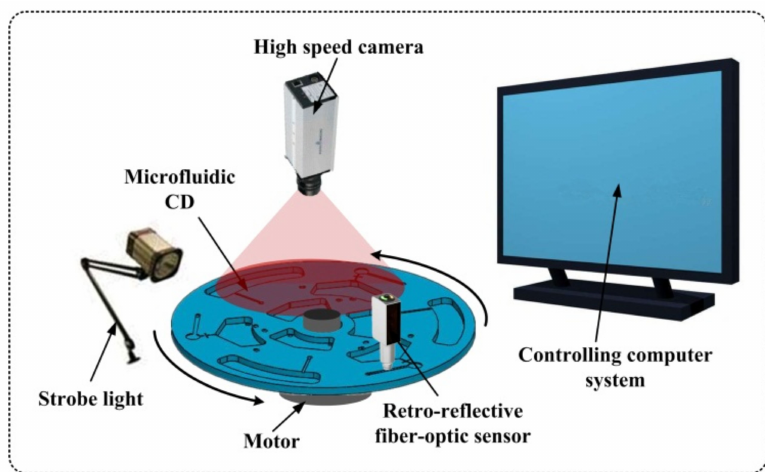
Figure 2. Illustration of the spinning test system, consisting of a computer controller connected to a stroboscopic imaging system over a servo-controlled spinning platform. The retro-reflective fiber-optic sensor was used to detect disc position to allow strobe